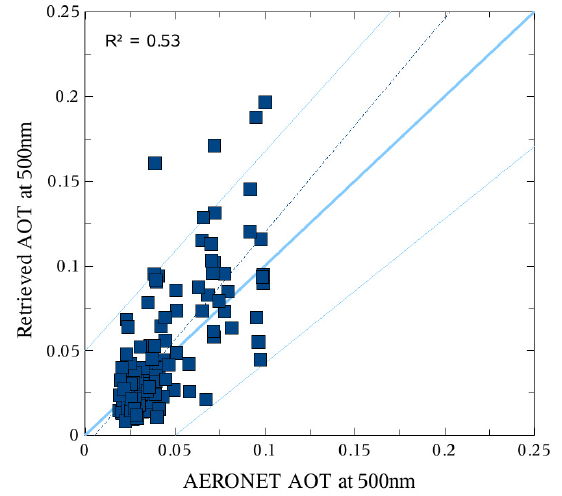
Fig. 9. Comparison of the retrieved AOTs derived from AATSR product as 3.7µm and AERONET AOTS for station OPAL. The dashed line represents the linear regression of the data. RMSD=0.0283, R 2